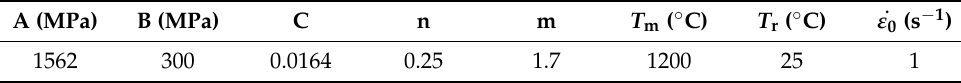
Table 2. Johnson–Cook material parameters